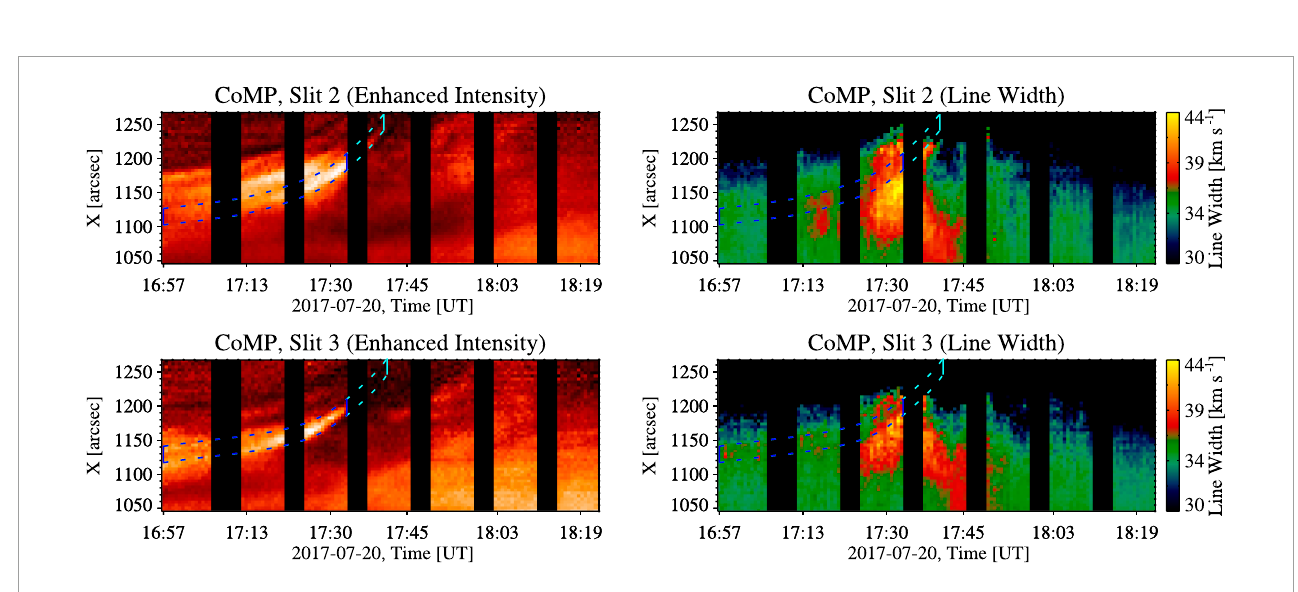
FIGURE 6 The left panel shows the CoMP Fe XIII 10747 Å enhanced-intensity space-time maps, and the right panel shows the Fe XIII line width space-time maps. The blue dashed curve in each slit space-time map is fitted using the height-time values obtained from spline fitting AIA 193 Å intensity space-time map of the respective slit. The eruption is further tracked in the CoMP FOV outside the AIA FOV and is shown by the cyan curve. Black stripes represent gaps in data.